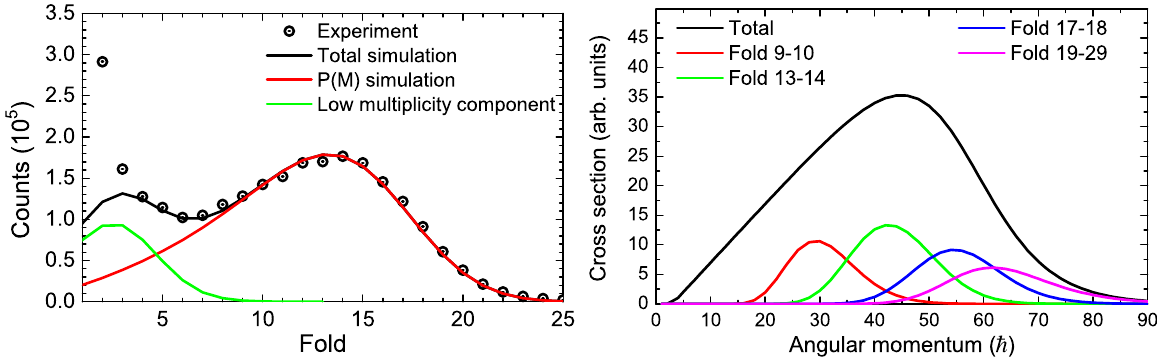
Figure 1. (Left) Experimental and simulated fold distribution in 28 Si + 116 Cd reaction at 170 MeV beam energy. (Right) Angular momentum distribution corresponding to di ff erent fold bins in the same